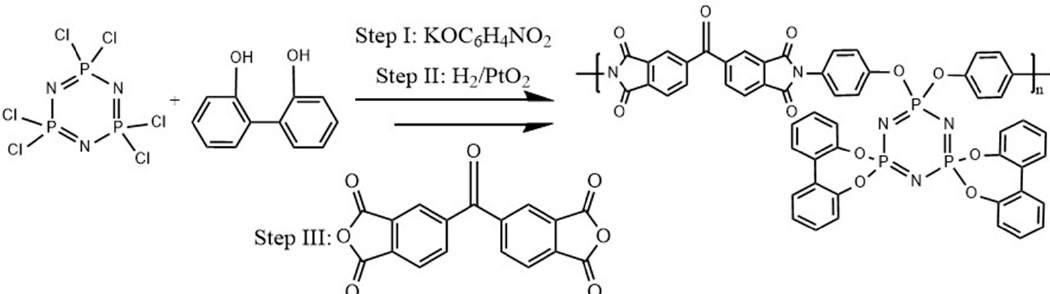
Scheme 4. Schematic representation of the synthesis of polyimide copolymer containing amine- functionalized phosphazene [136].